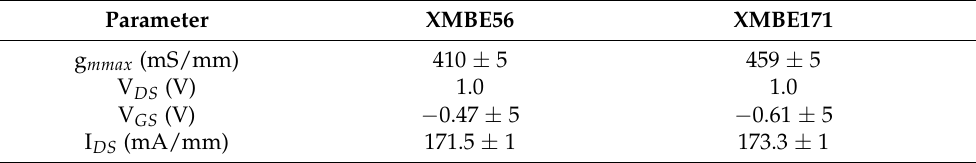
Table 4. RF biasing conditions for XMBE56 (improved) and XMBE171 (conventional).